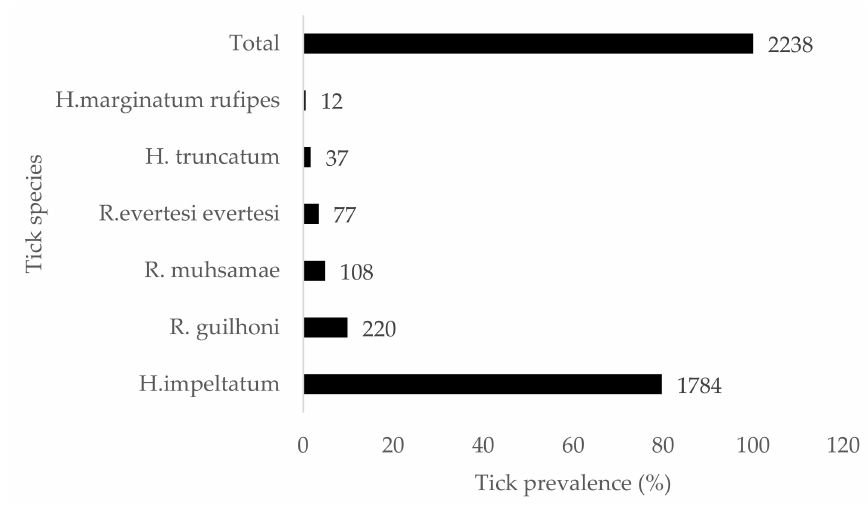
Figure 6. Prevalence of tick